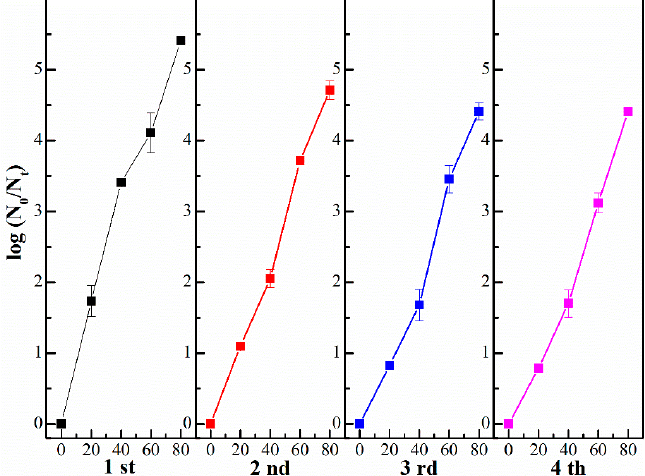
Figure 9. Cycling experiments of bacteriophage f2 by AgCN composite photocatalysts under visible light irradiation.